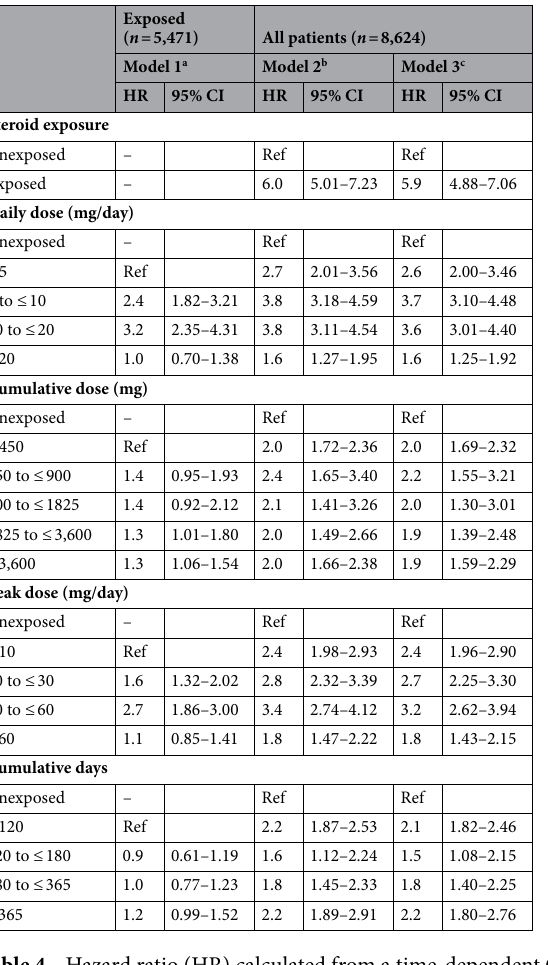
Table 4. Hazard ratio (HR) calculated from a time-dependent Cox model with each glucocorticoid level of exposure variable. CI confidence interval, Ref. reference. a Model 1 was with exposed patients only. b Model 2 was with all study populations. c Model 3 was adjusted for age group (≥ 60 years) and sex with all study